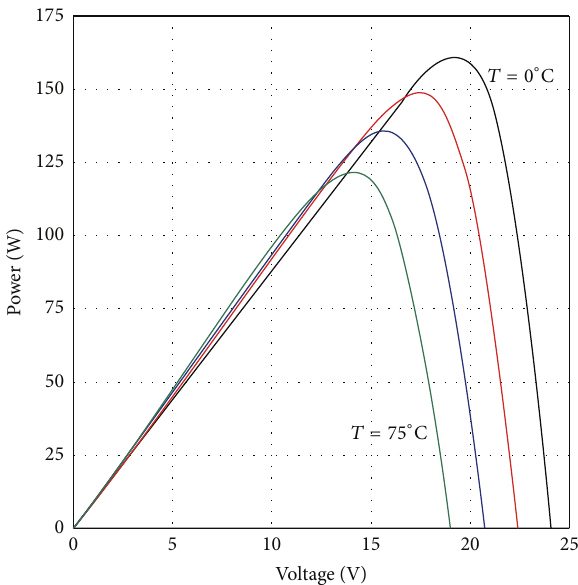
Figure 15: Matlab model 𝑃 - 𝑉 curves for various temperatures (BSM-150, 𝐺 = 1000 W/m 2 , 𝑇 = 0 , 25, 50, 75 ∘